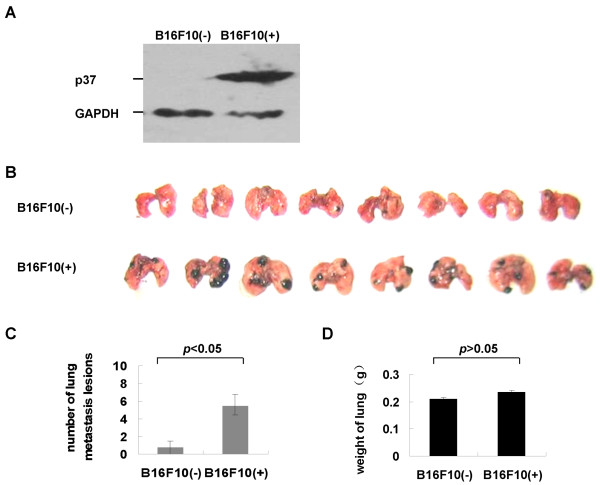
Mycoplasma hyorhinis stimulates tumor metastasis in C57BL/6 mice. A. Verification of Mycoplasma hyorhinis infection in B16F10 cells by Western blot with PD4 antibody. B. Macroscopic documentation of lung metastasis lesions of mice injected with infected (+) or uninfected (-) B16F10 cells. C. The average numbers of metastatic lesions for each mouse. The infected group had more metastasis than the uninfected group (P < 0.05). D. The average weight of lungs of mice injected with B16F10 cells. No difference was observed (P > 0.05)